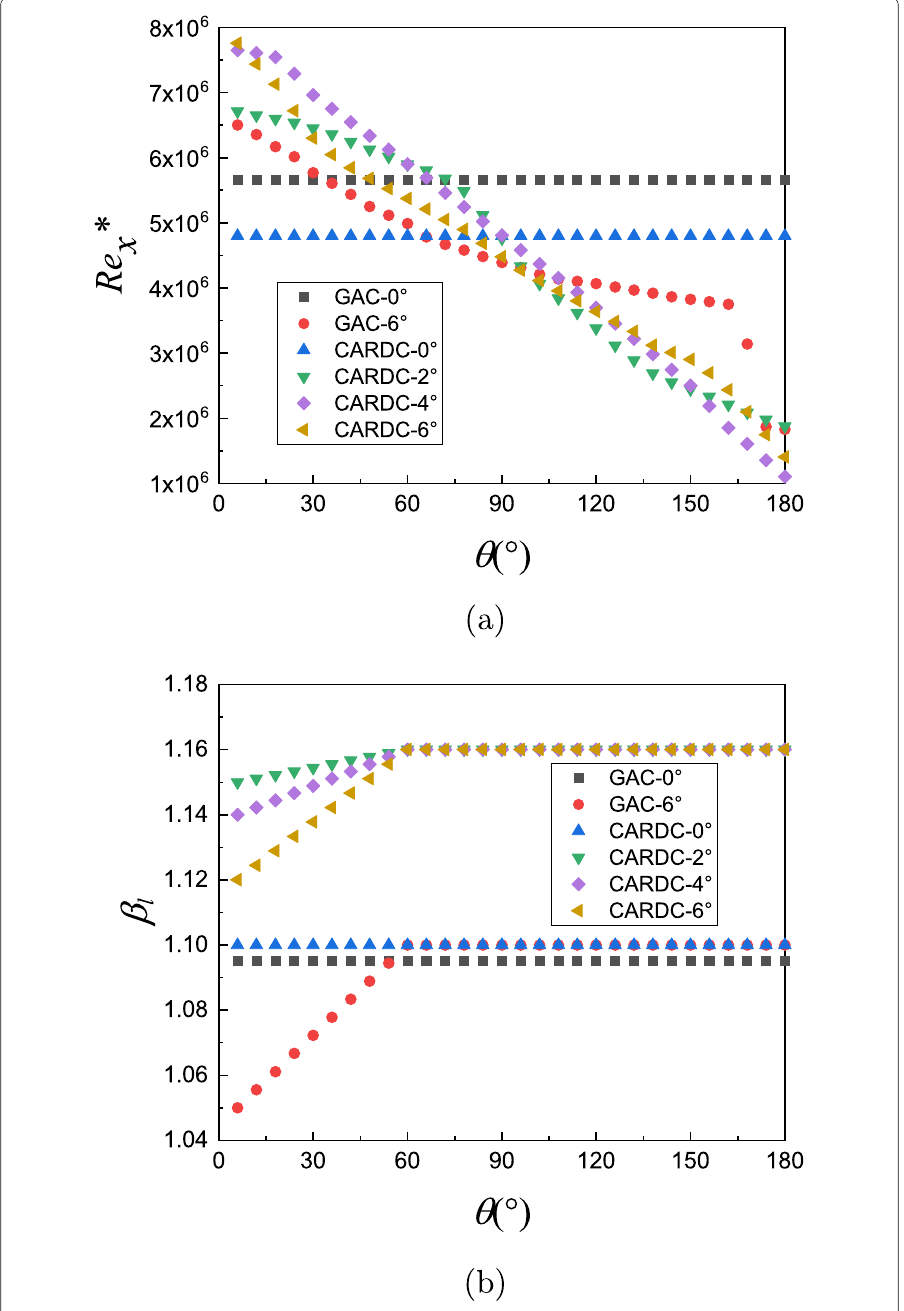
Fig. 1 Variations of a the transition center Reynolds number Re x ∗ and b the transition overshoot strength parameter β l with the circumferential angle θ for the GAC and CARDC test